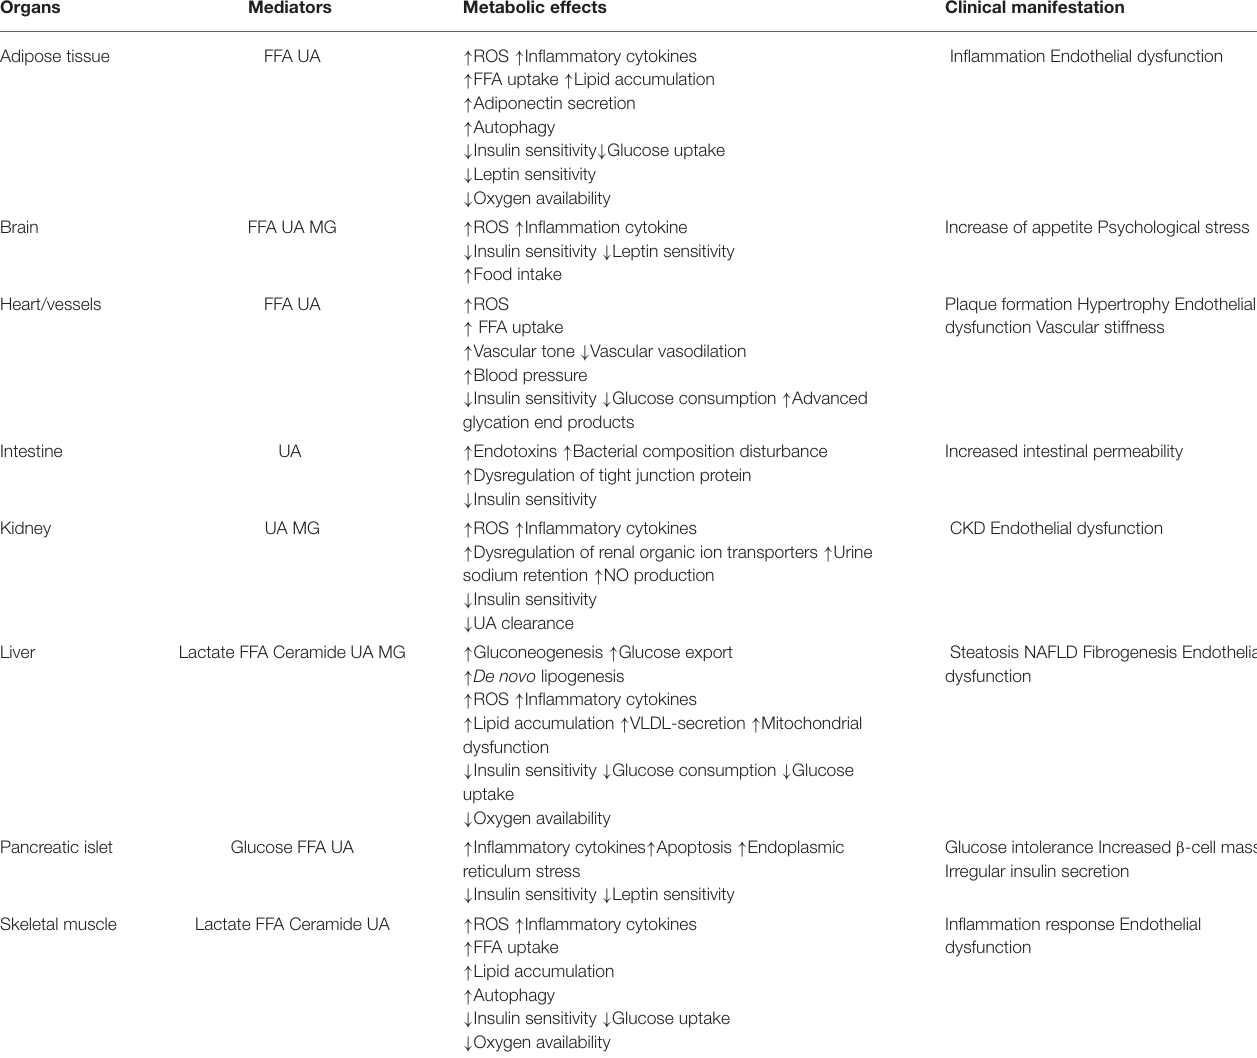
TABLE 2 | Effects of a high fructose dietary intake on major organs.